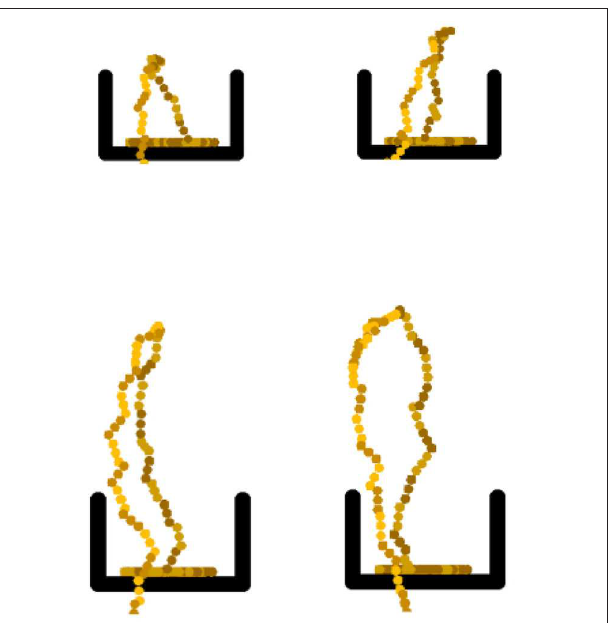
FIGURE 10 | A simulated time sequence of the fountain evolution using the pasta model. The times are 0.5, 2.0, 2.5, and 3.0 s and h 1 = 1.8